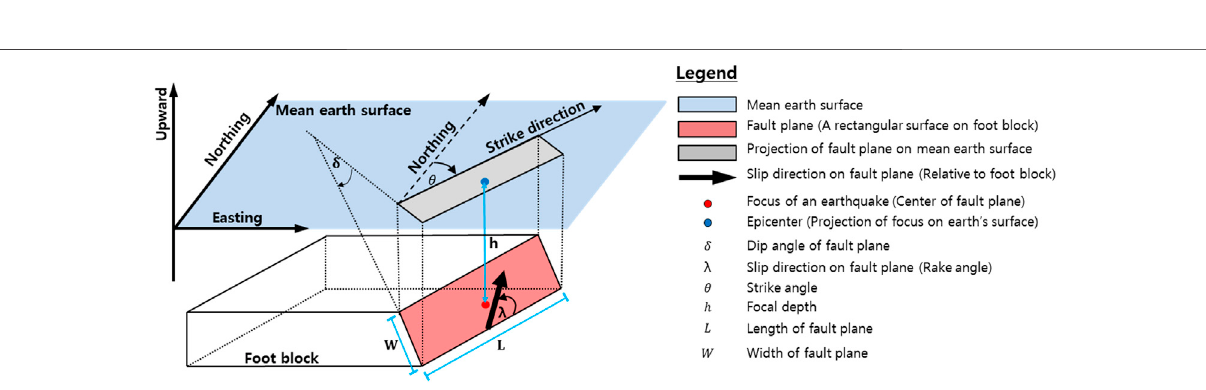
Frontiers in Earth Science |